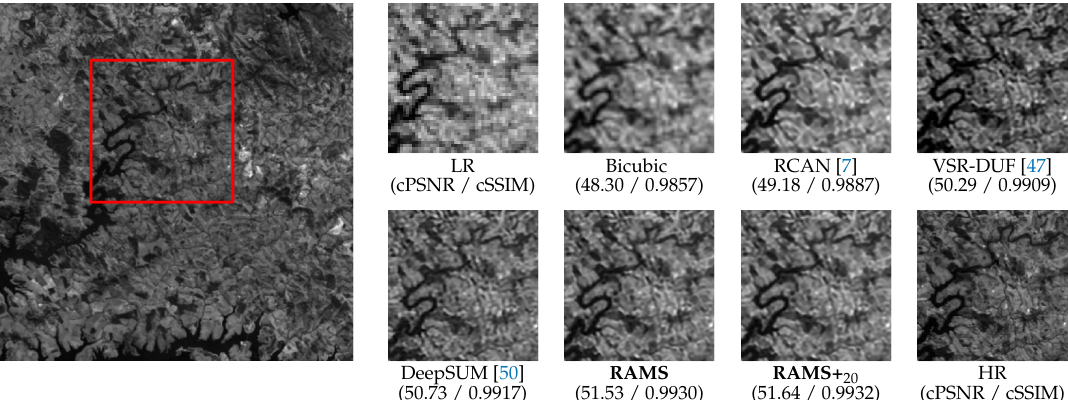
Figure 6. Qualitative comparison between different methods on RED imgset0302.